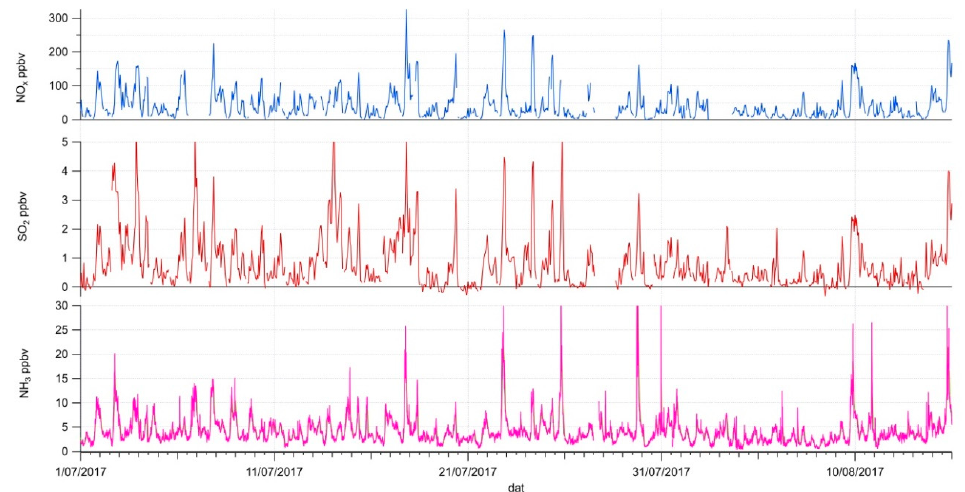
Figure A4. Time series comparing NH 3 measured by the OP-FTIR system and NO x and SO 2 as measured at the Mobile Air Quality Station in Western